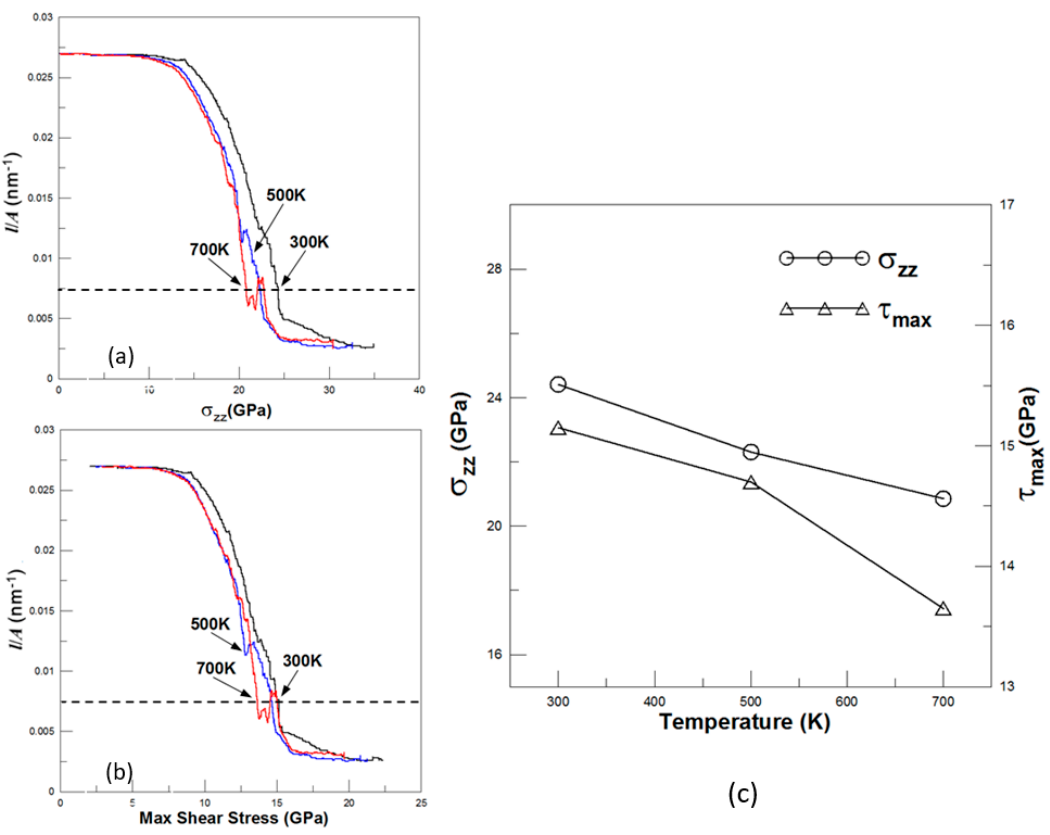
Figure 21. Relationship between stress and resistance represented by l/A at different temperatures ( a ) resistance vs. axial stress; ( b ) resistance vs. maximum shear stress; ( c ) comparison of stress at l/A = 0.0075 at different temperatures.